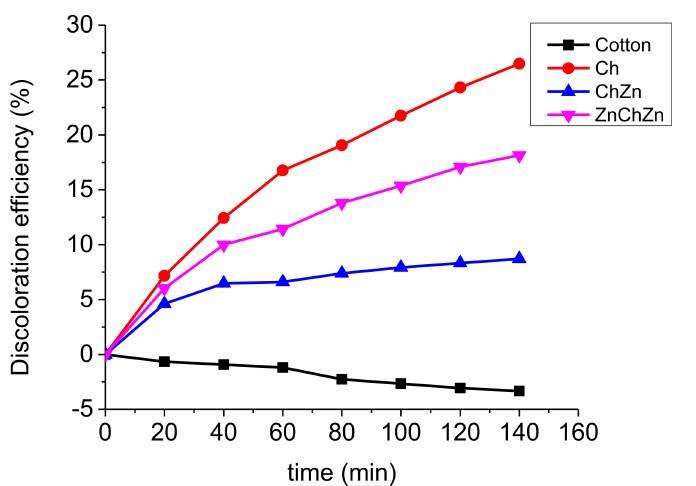
Figure 10. Discoloration of Drimarene K-7B dye water solution (0.04 g L − 1 ) according to time by textile materials: pristine cotton, Ch, ChZn, and ZnChZn (4 g L − 1